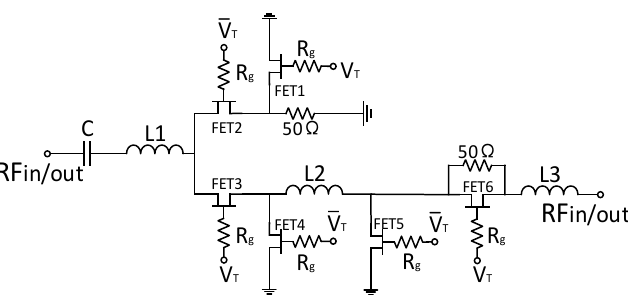
Figure 2. The structure of the absorptive single pole single throw (SPST) switch. Table 1. The parameters of SPST switch design.